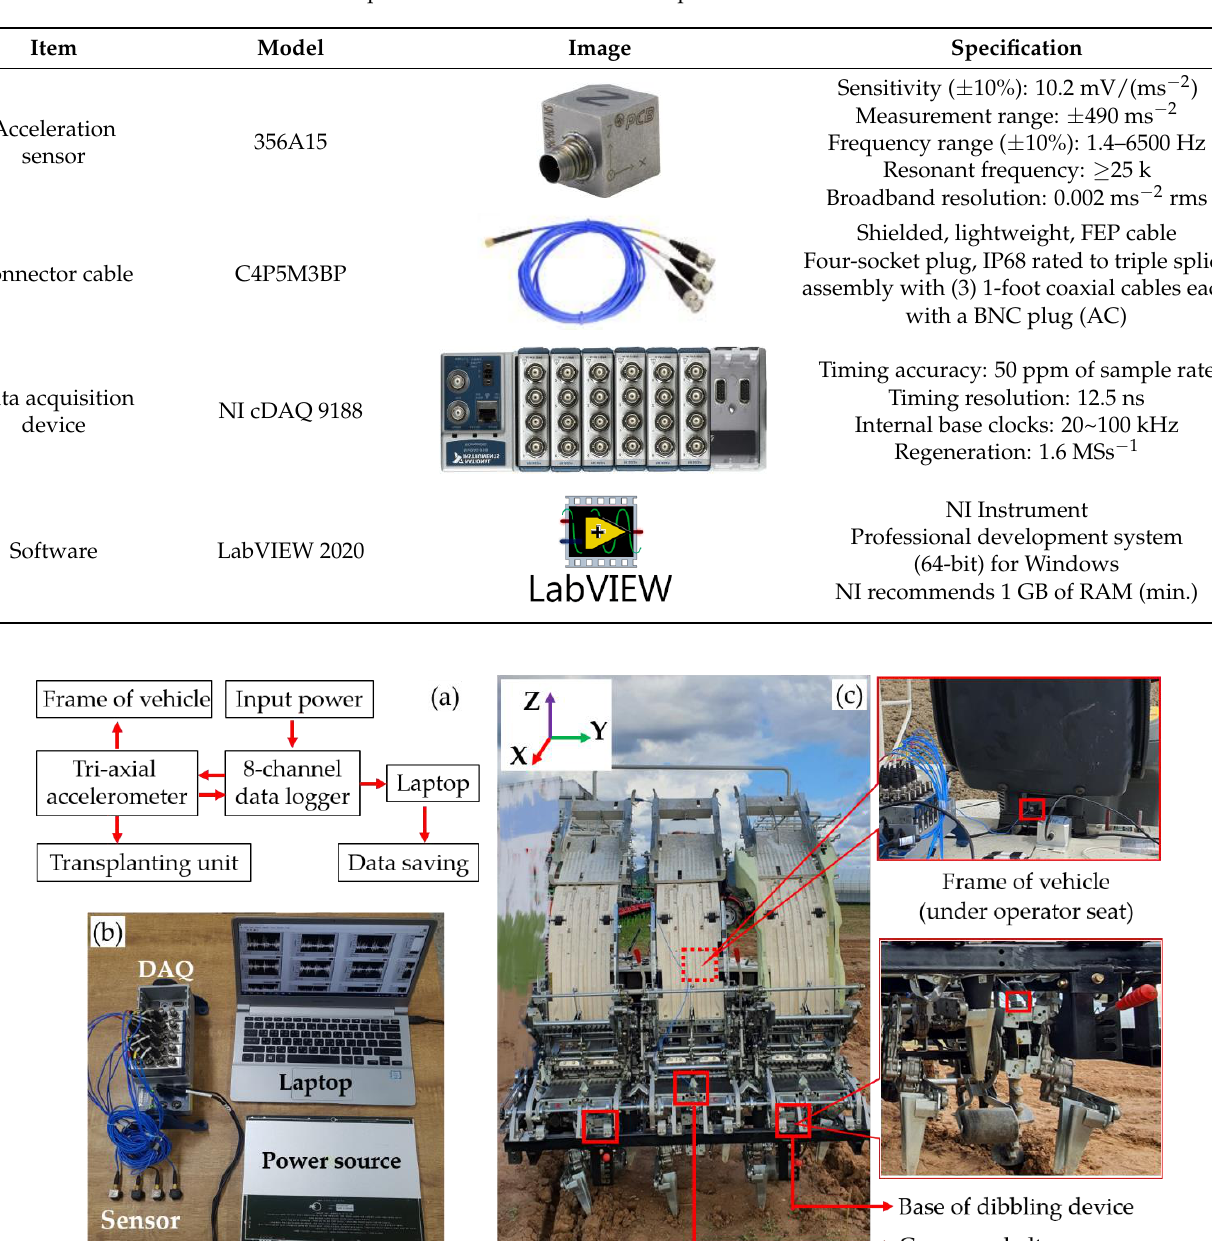
Table 2. Specifications of the vibration exposure measurement instruments and software.